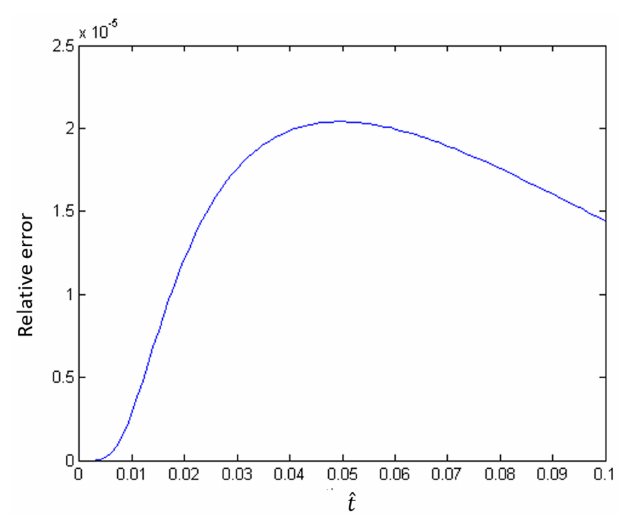
Figure 3. Maximum relative error with hybrid splitting method for constant material coefficients.